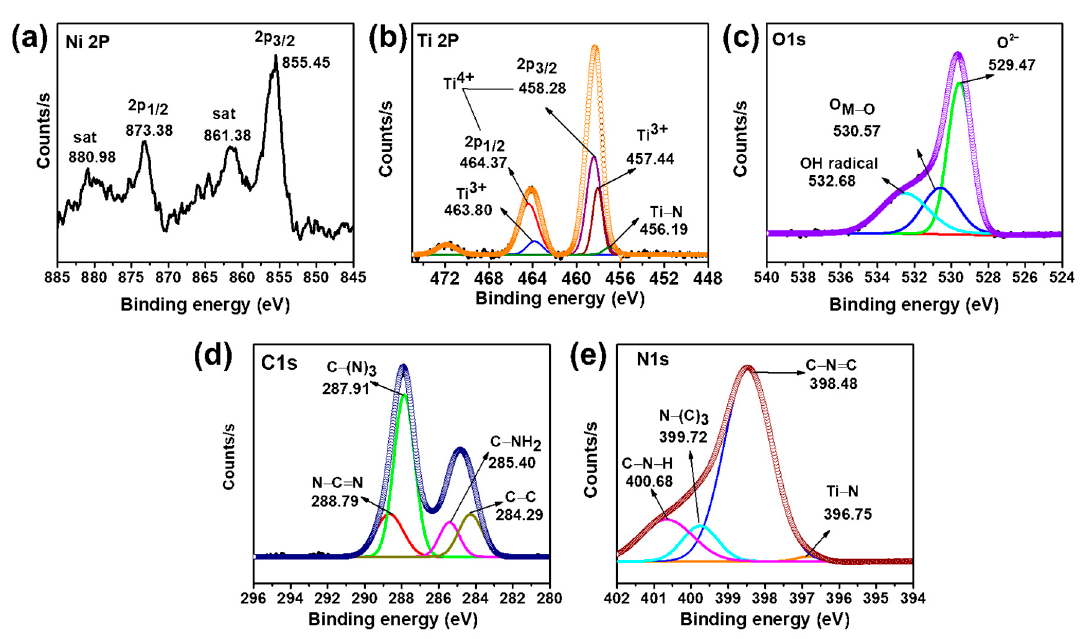
Figure 5. X-ray photoelectron spectra (XPS) of the gnT6040 hybrid sample with high-resolution spectra for ( a ) Ni 2p, ( b ) Ti 2p, ( c ) O 1s, ( d ) C 1s, and ( e ) N 1s signals.